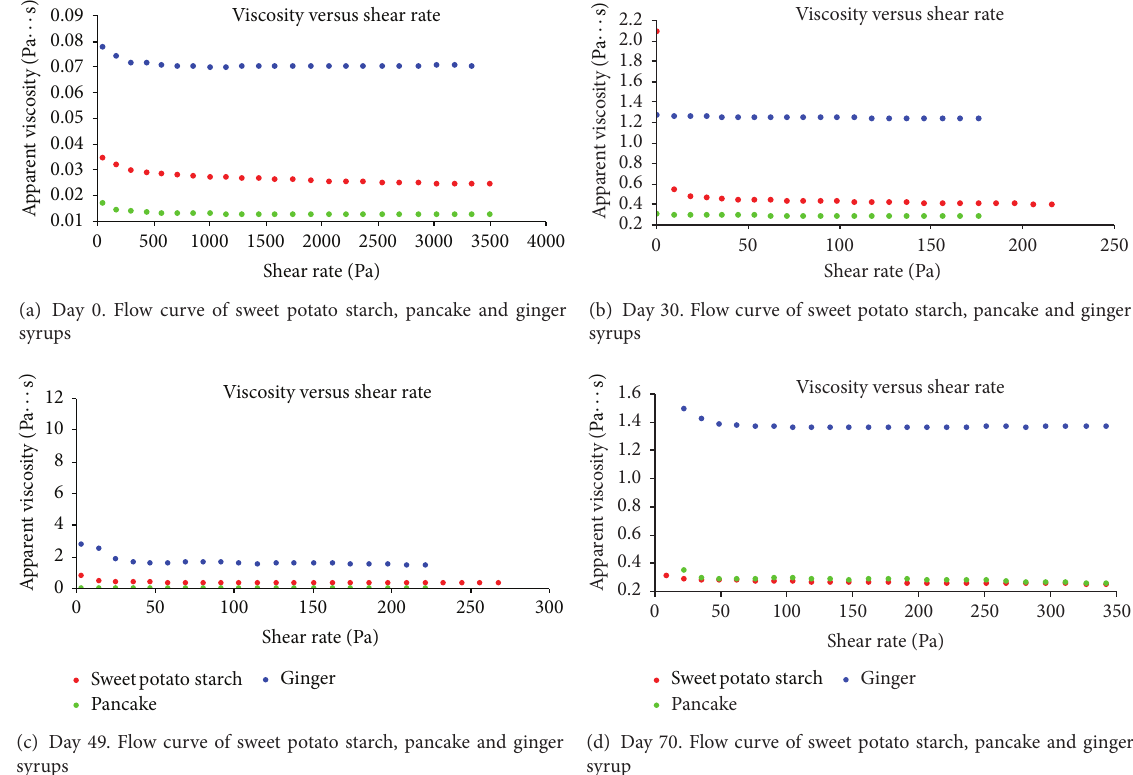
(c) Day 49. Flow curve of sweet potato starch, pancake and ginger syrups Figure 2: Viscosity versus shear rate for the SPSS, pancake, and ginger syrups at (a) Day 0, (b) Day 30, (c) Day 49, and (d) Day